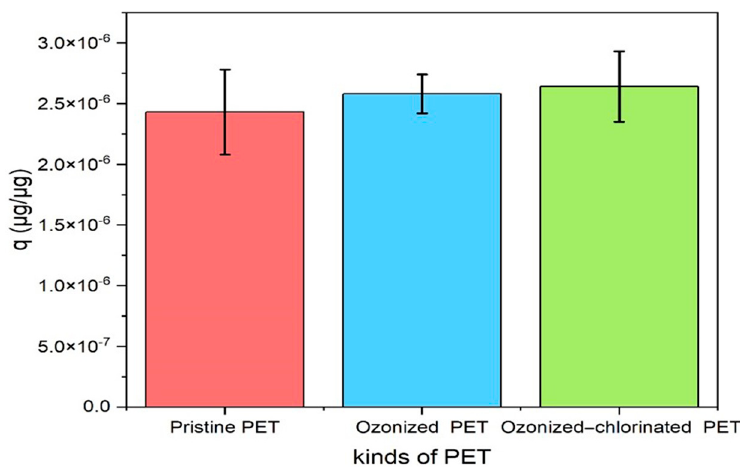
Figure 6. The adsorption capacity of the three PETs on TBM after 24 h.